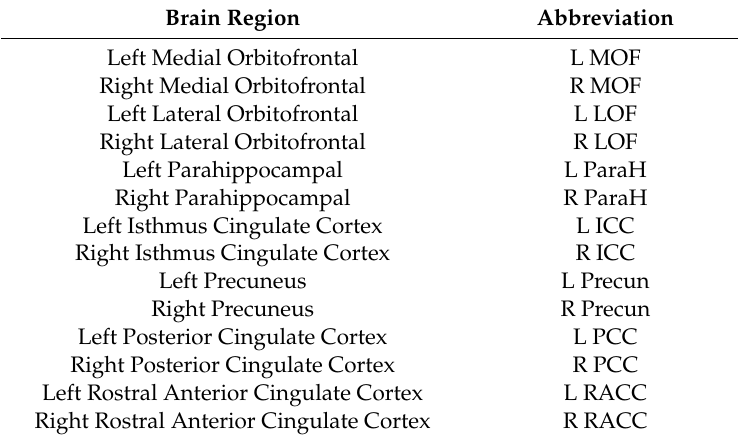
Table 2. Default mode network brain regions and